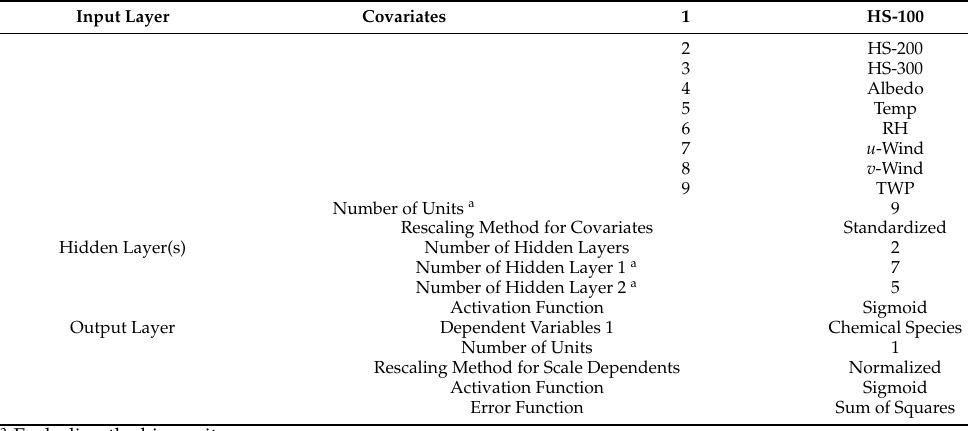
Table A2. Network information related to the machine learning